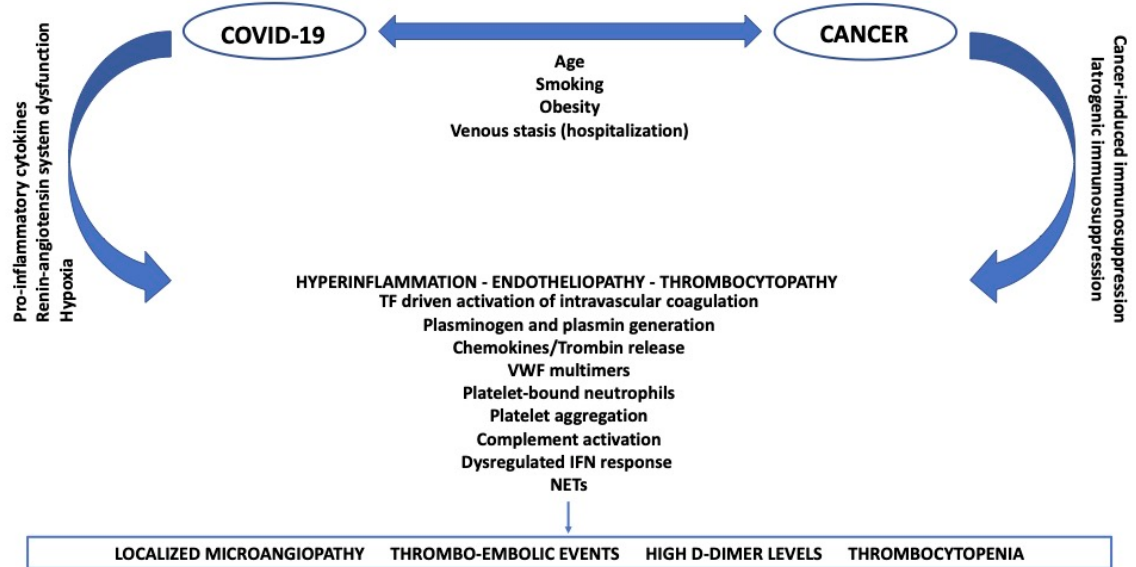
Figure 1: Mechanisms of thrombosis in SARS-CoV-2 infected patients with cancer: a synergic process COVID-19: coronavirus disease 2019; TF: tissue factor; VWF: von Willebrand factor; IFN: interferon; NETs: neutrophil extracellular